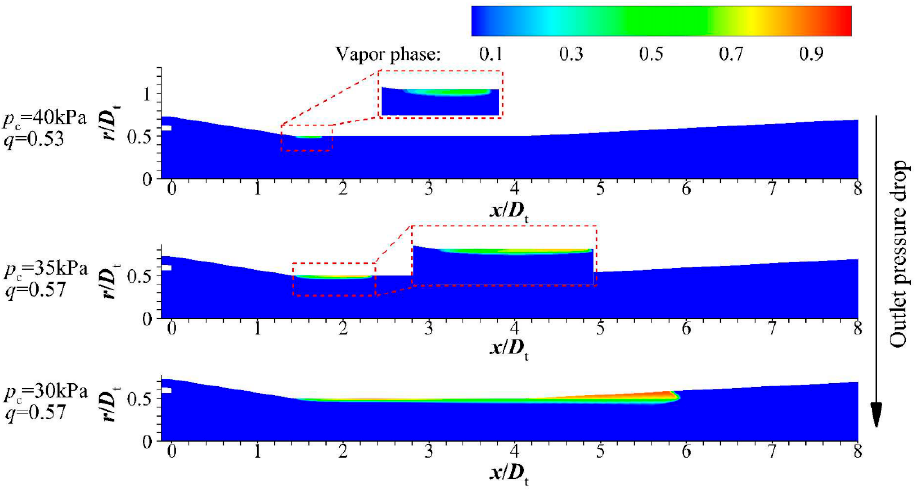
Figure 13. Cavitation development in the EAJP.